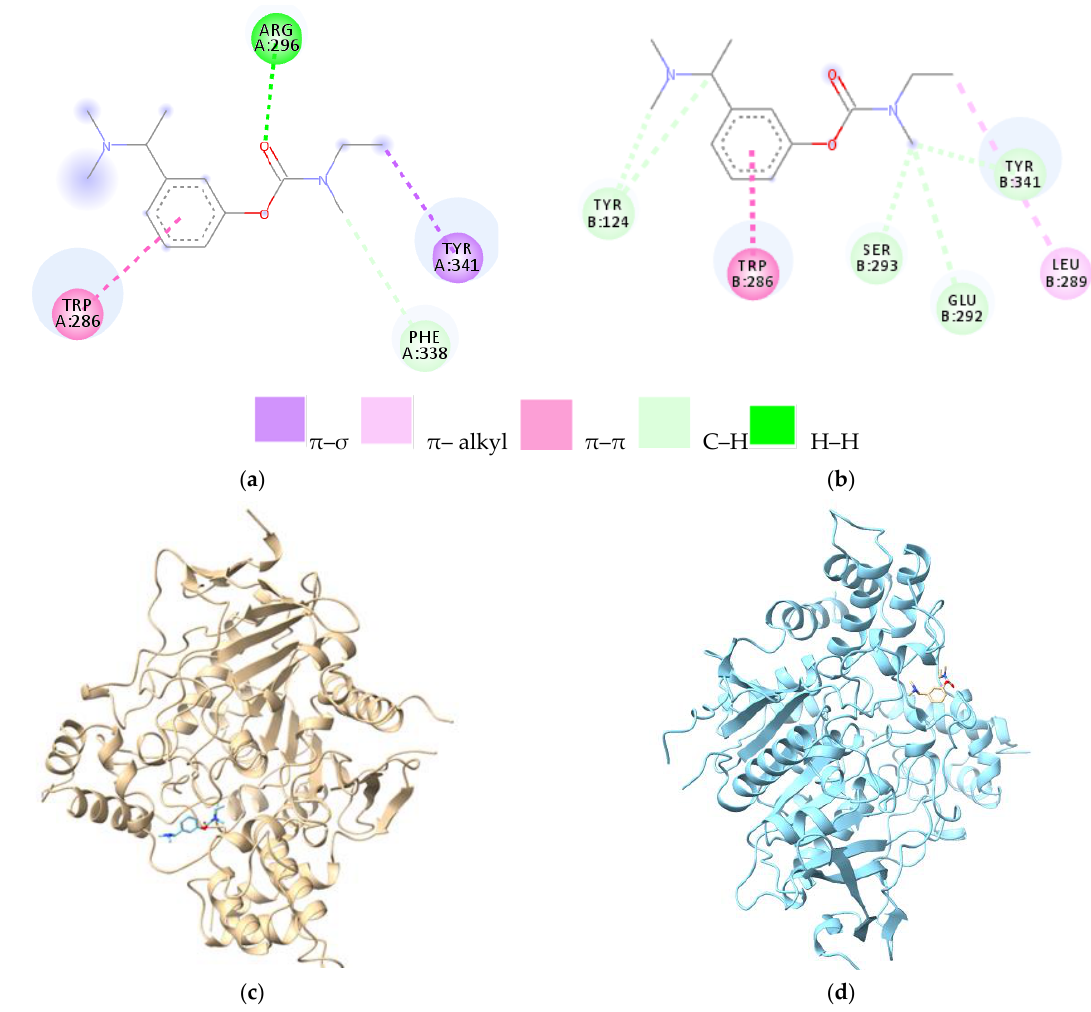
Figure 3. 2D and 3D diagrams representing the links between ligand and protein; ( a ) rivastigmine – AChE (chain A) complex; ( b ) rivastigmine – AChE (chain B) complex; ( c ) 3D structure of the donepezil— AChE (chain A) complex A; ( d ) 3D structure of the donepezil–AChE (chain B) complex. Legend: TYR—tyrosine; TRP—tryptophan; PHE—phenylalanine; LEU—leucine; SER—serine; ARG—arginine; GLU—glutamic acid. The letters A and B represent the chains; the number represents the numbering of the amino Table 2. Rivastigmine – AChE ligand – receptor interactions at the A and B chains.